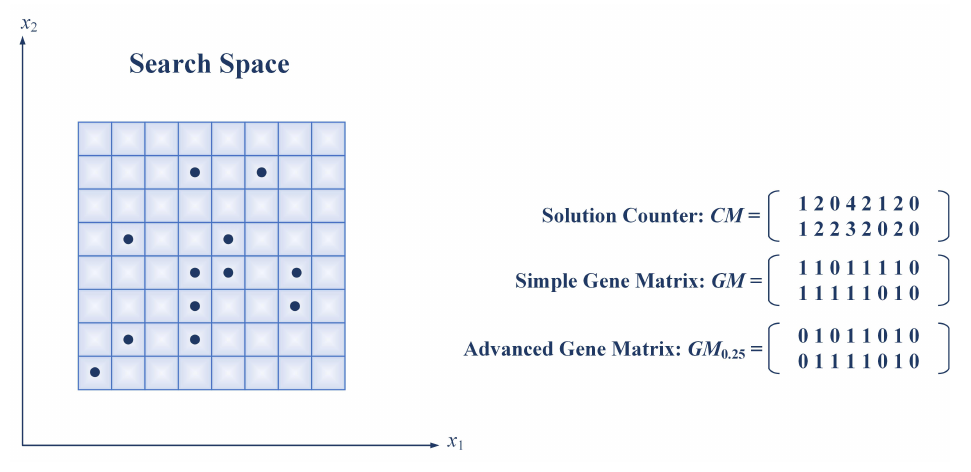
Figure 1. An example of the Gene Matrix in R 2